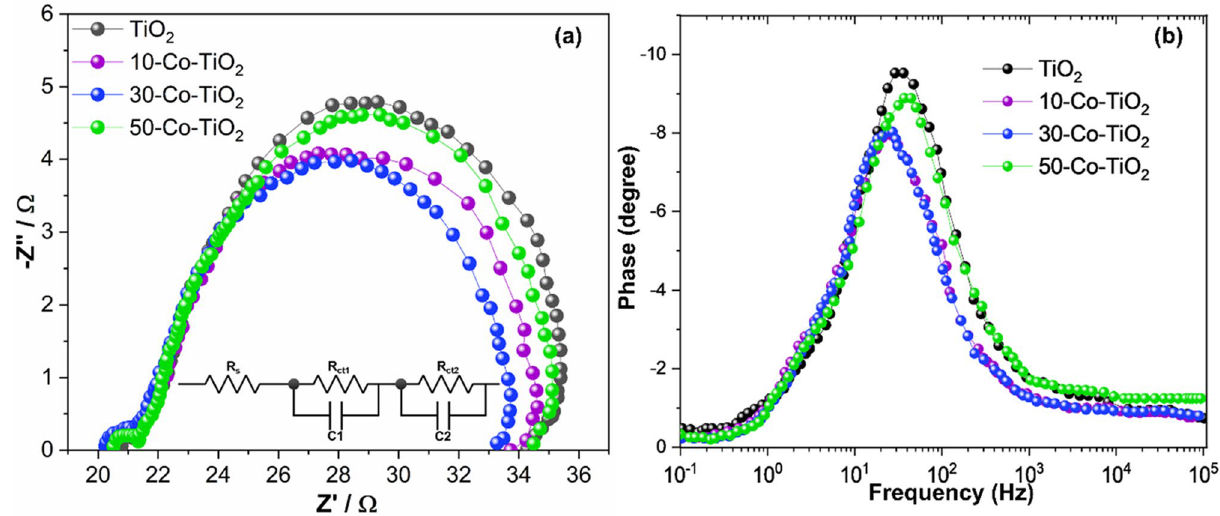
Figure 7. ( a ) Nyquist and ( b ) Bode impedance plot for TiO 2 and different Co 2+ ion doped TiO 2 photoanode- based DSSCs. The equivalent circuit used to fit the impedance curve is inserted in ( a ).